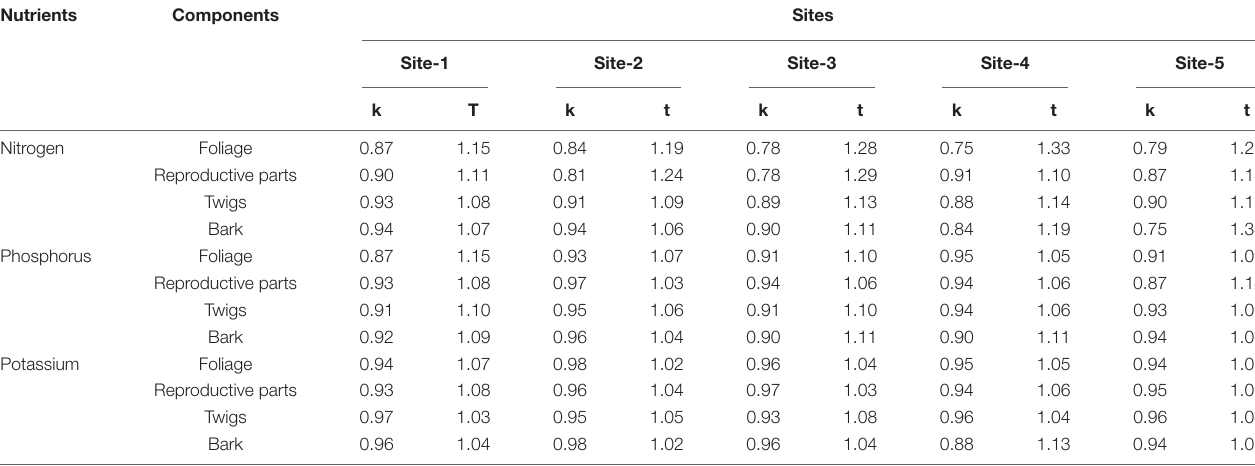
TABLE 8 | Turnover rate (k, yr − 1 ) and turnover time (t, year) of the nutrients on the shrub floor across selected sites. Nutrients